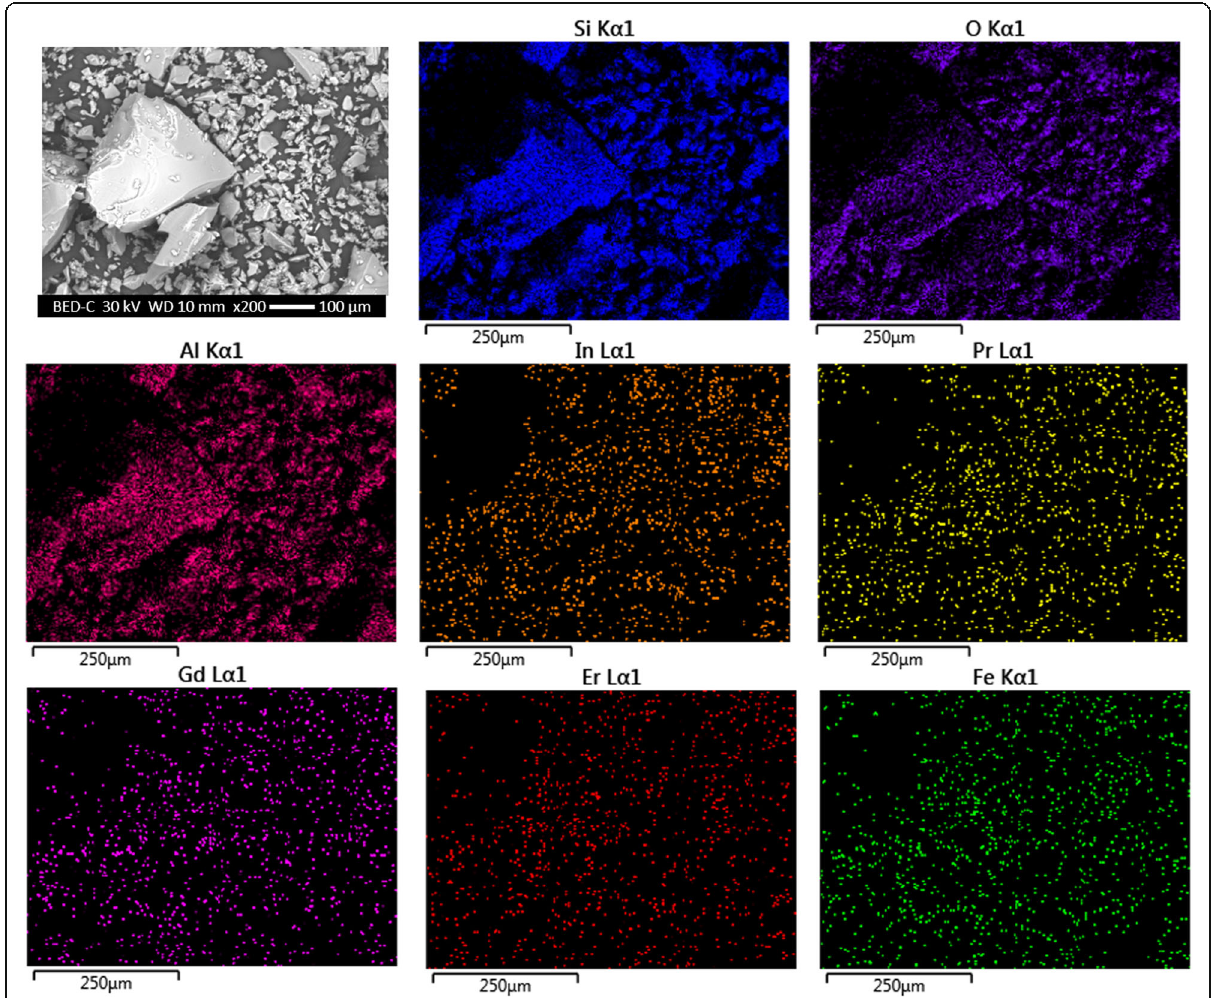
Fig. 3 Elemental mapping at the microstructural level by scanning electron microscopy (SEM) with energy dispersive X-ray spectrometry (EDS) of milled LCD screen